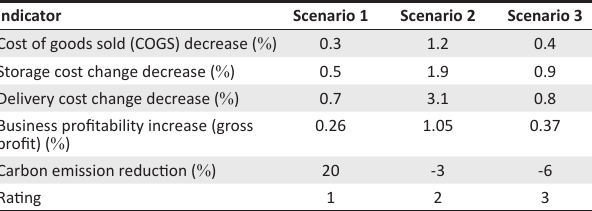
TABLE 15: Source case study results per